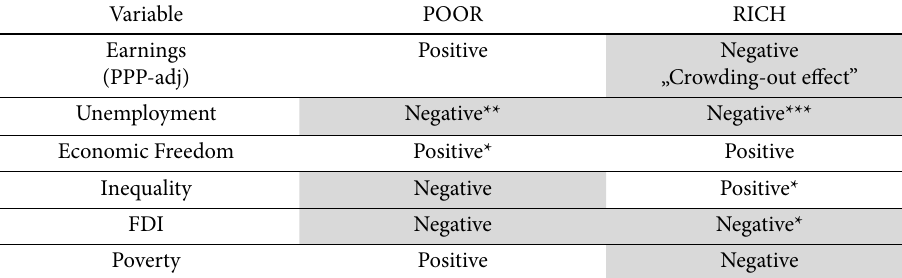
Table 3. Summary of